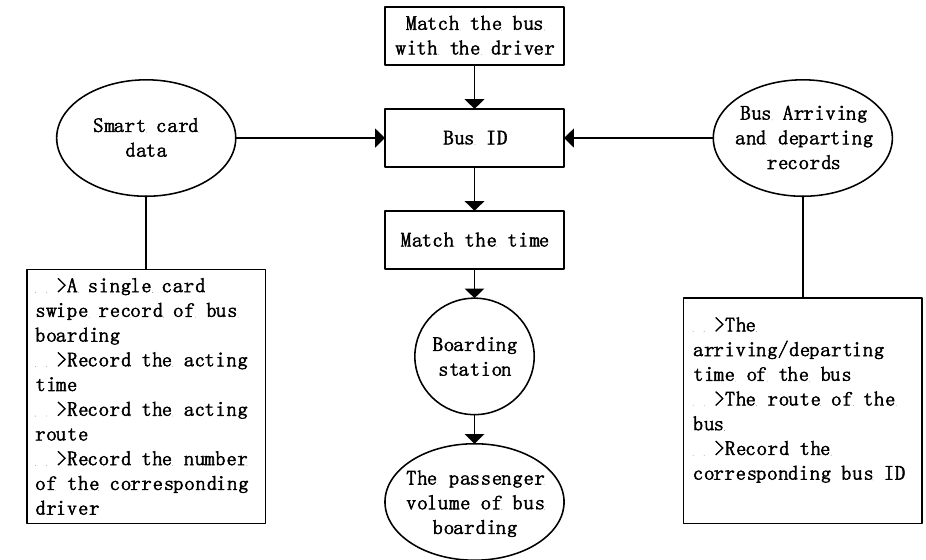
Figure 6. Flowchart of passenger flow statistics.